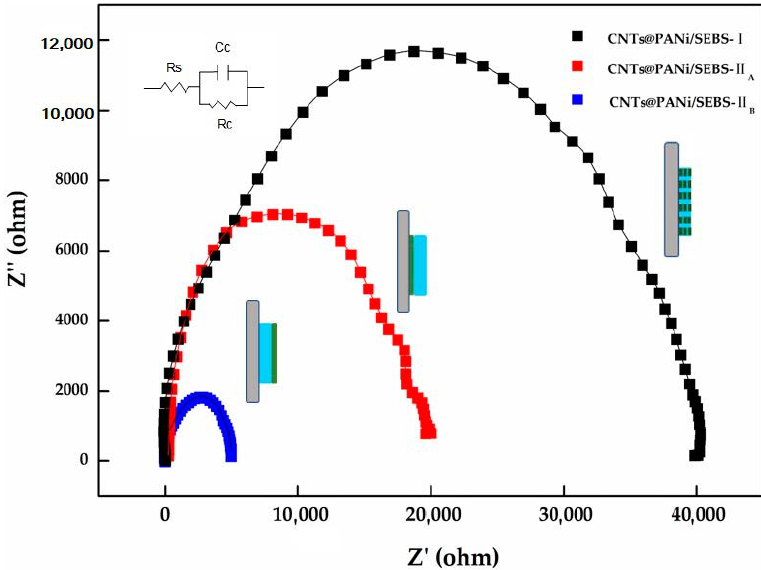
Figure 6. Electrochemical impedance curves of CNTs@PANi / SEBS composite films. Table 1. Impedance parameters of CNTs@PANi/SEBS composite films.